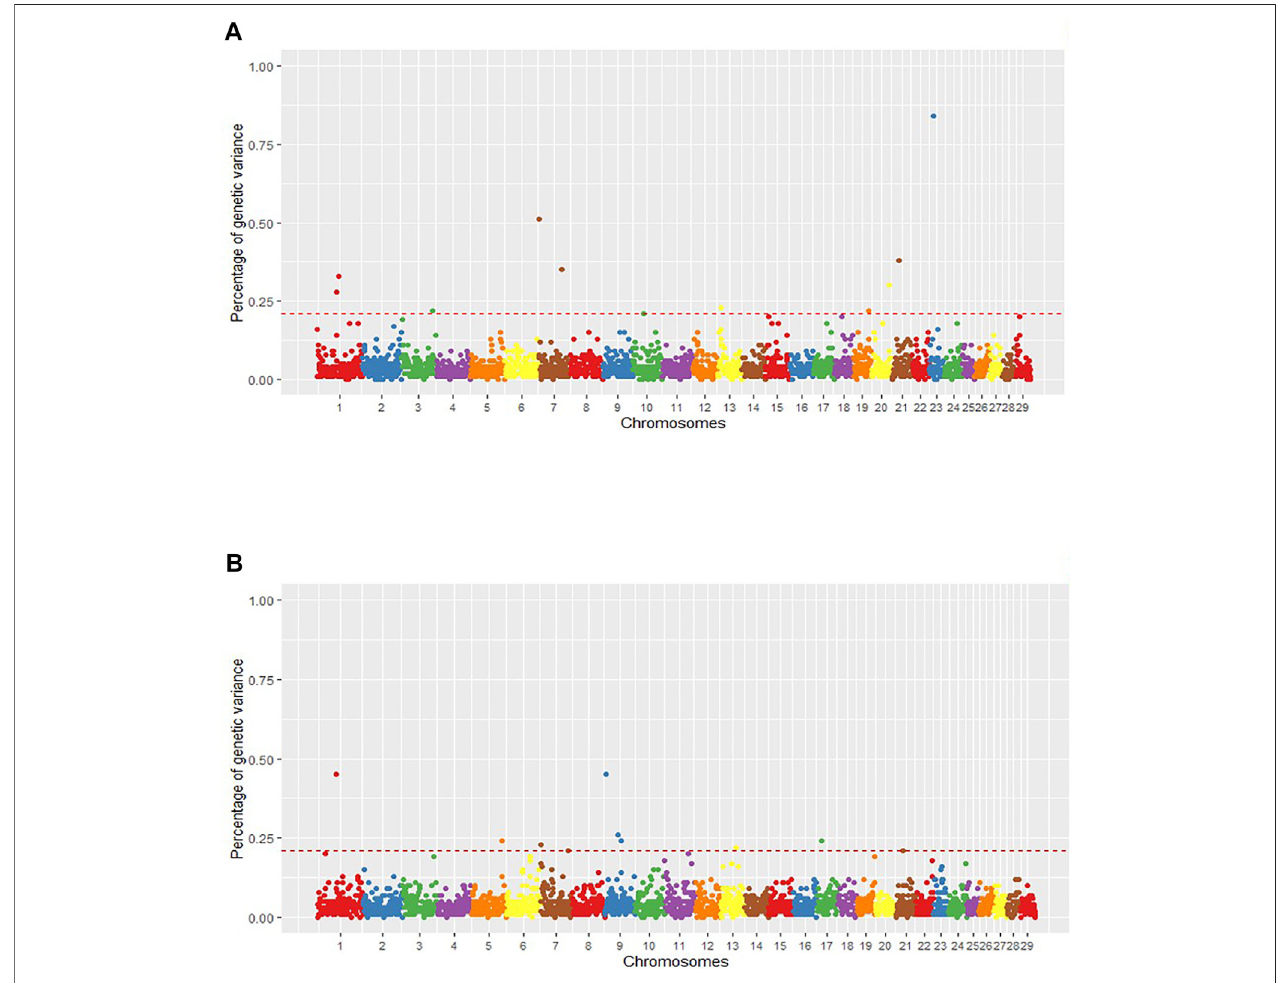
FIGURE 1 | Manhattan plot of the posterior means of the percentage of genetic variance explained by each 1 Mb SNP window across the 29 autosomal chromosomesforintramuscularfatcontent(IMF) (A) andbackfatthickness(BFT) (B) .TheX-axisrepresentsthechromosomes,andtheY-axis,thepercentageofgenetic variance explained by each SNP window. Red dashed lines delimit the relevant QTL